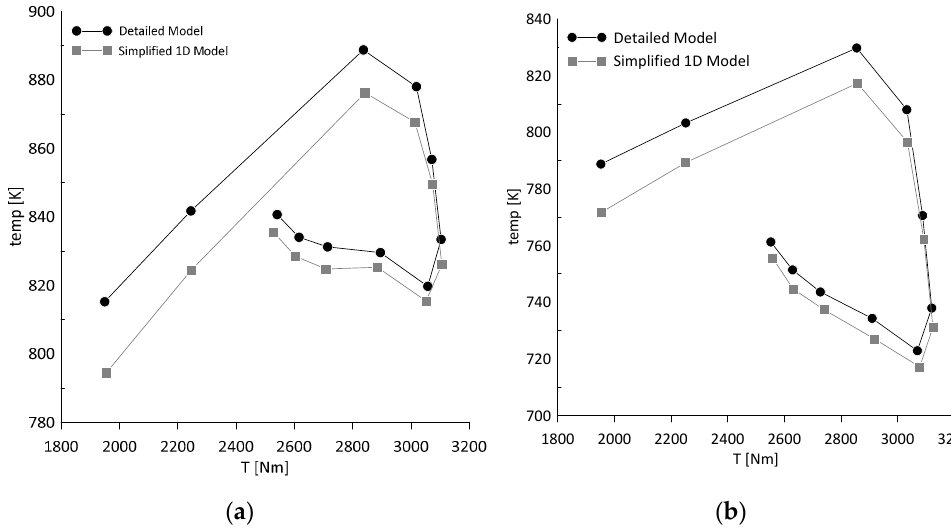
Figure 6. Exhaust manifold: Inlet ( a ) and Outlet ( b ) temperature.